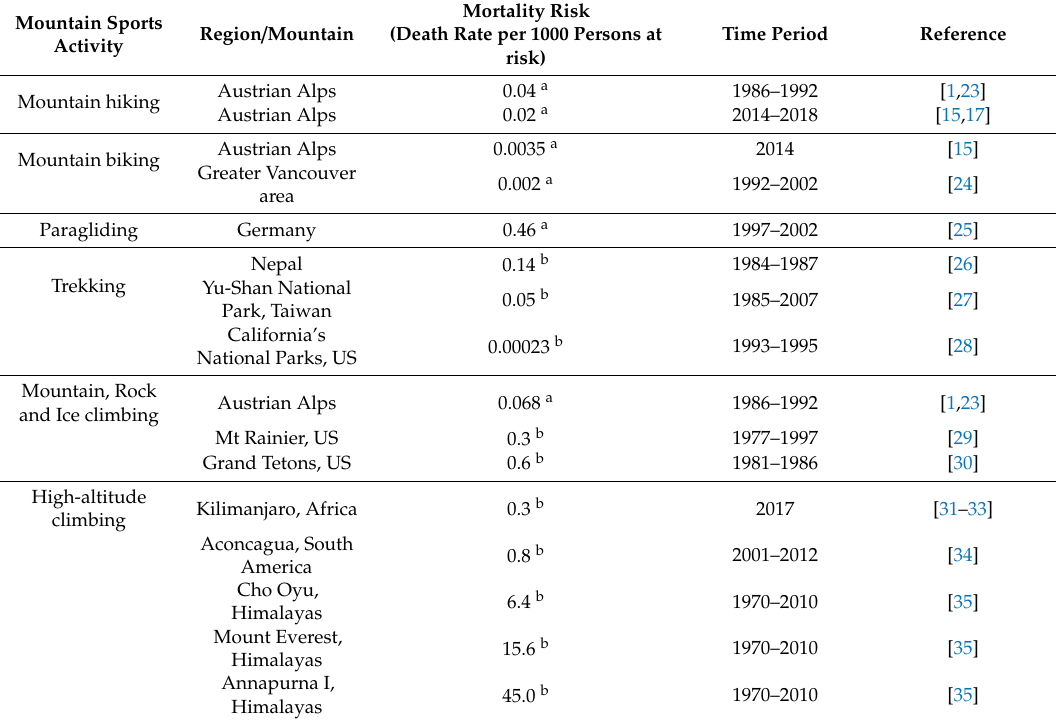
Table 1. Selected mortality rates during di ff erent sport activities in the